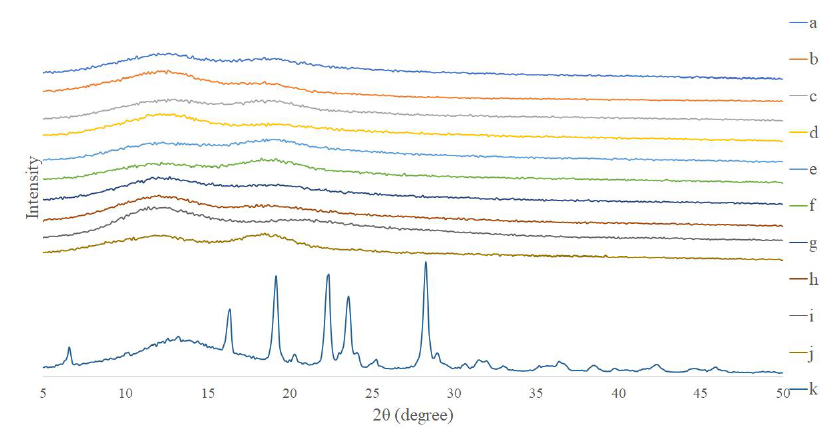
Figure 3. X-ray diffractometry patterns of resveratrol, PVP, HPBCD, and different ratio formulations (Res ： PVP ： HPBCD) of resveratrol nanofibers. ( a ) 1:16:40, ( b ) 1:8:40, ( c ) 1:4:40, ( d ) 1:16:20, ( e ) 1:8:20, ( f ) 1:4:20, ( g ) PVP:HPBCD = 1:5 (blank nanofiber), (h) physical mixture of PVP and HPBCD, (i) pure PVP, (j) pure HPBCD, (k) pure resveratrol.